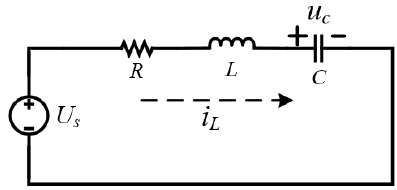
Figure 6. Equivalent circuit of capacitor charging stage.